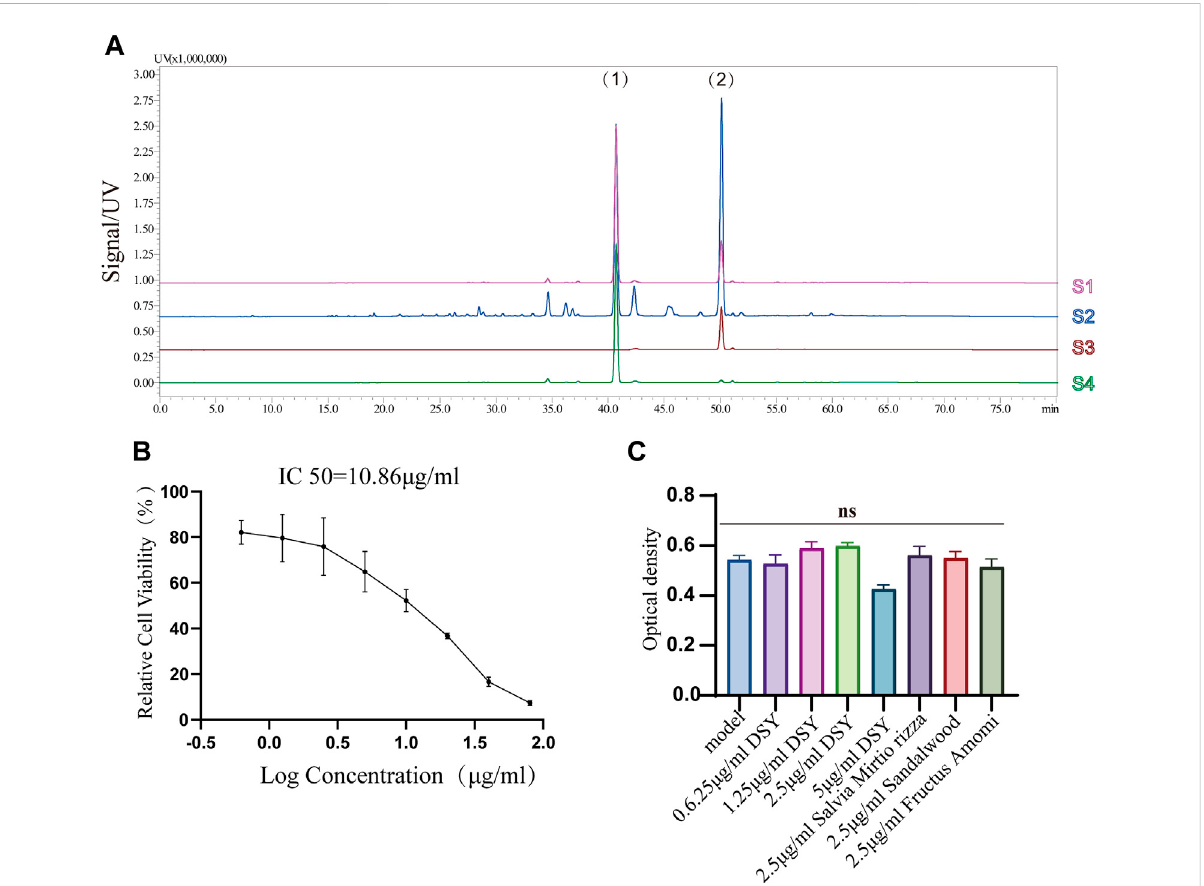
FIGURE 3 (A) HPLC chromatographic fi ngerprintsofDSY.(1)and(2)representcryptotanshinoneandtanshinoneIIAindividually.S1: